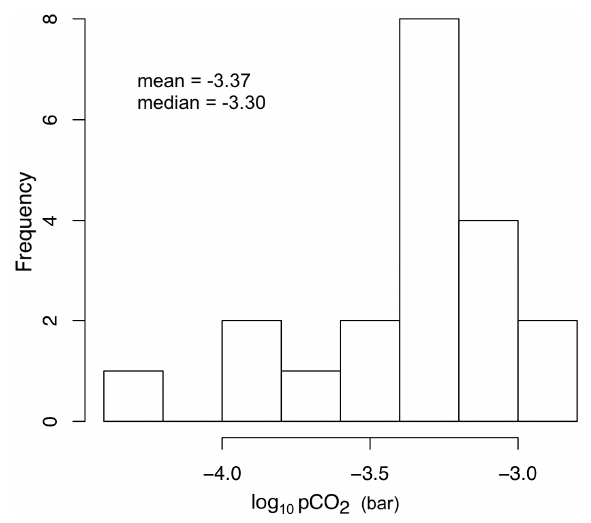
Figure 5. Histogram of log 10 pCO 2.